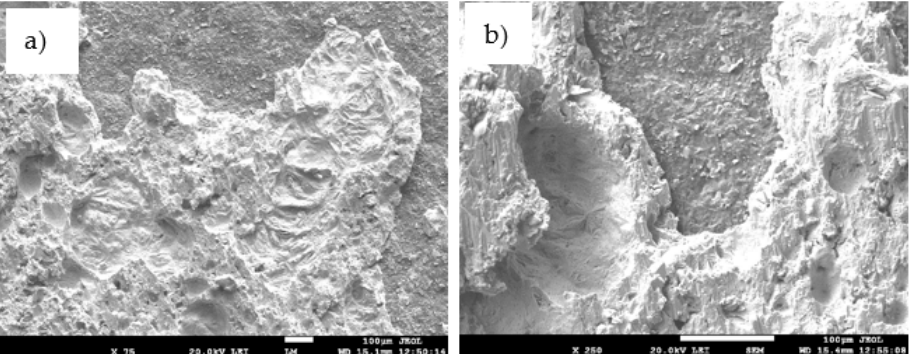
Figure 25. The fractured surface of the soldered joint of SiC/Sn5Sb3Ti/CuSiC; ( a ) magnification 75×; ( b ) magnification 250× .